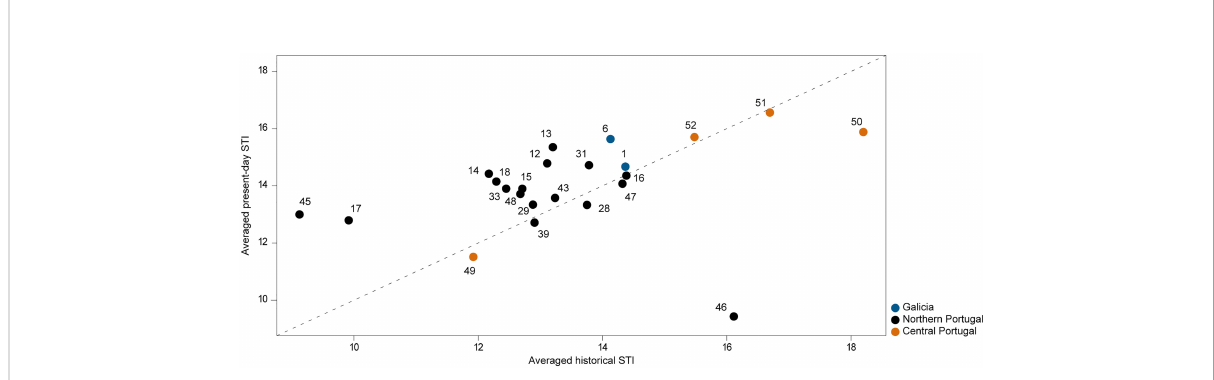
FIGURE 5 Comparison between averaged Species Temperature Index of sites in the present (averaged present-day STI) with averaged Species Temperature Index of sites in the past (averaged historical STI). Orange circles represent sites in central Portugal, black circles represent sites in northern Portugal and blue circles represent sites in Galicia. The line y = x shows the theoretical position of points if there were no changes in average STI. Locations are depicted by an ID number, for more details see Supplementary Table 2